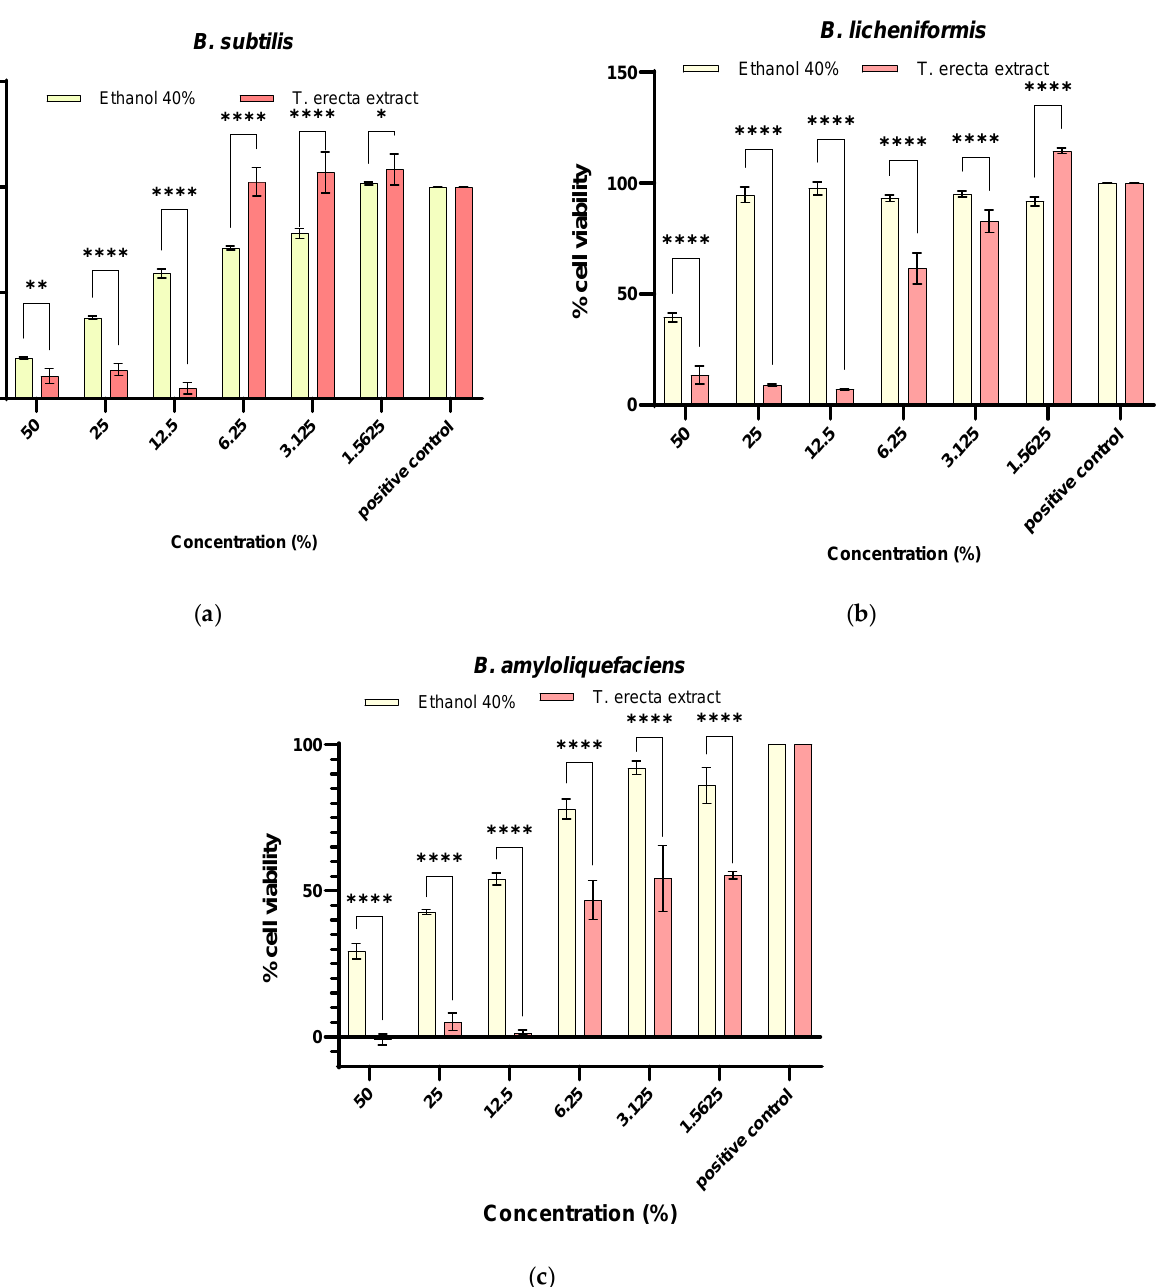
Figure 2. Quantitative antimicrobial activity against planktonic microbial strains belonging to Bacillus genus of T. erecta extract and the corresponding solvent concentration (* p < 0.05, ** p < 0.01, **** p < 0.0001, two-way ANOVA): ( a ) B. subtilis , ( b ) B. licheniformis , ( c ) B. amyloliquefaciens .